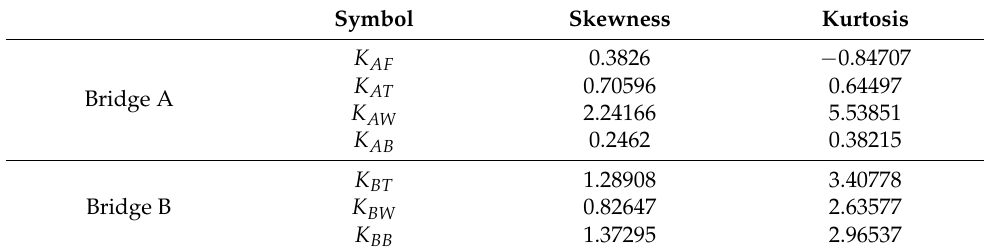
Table 8. Normal distribution